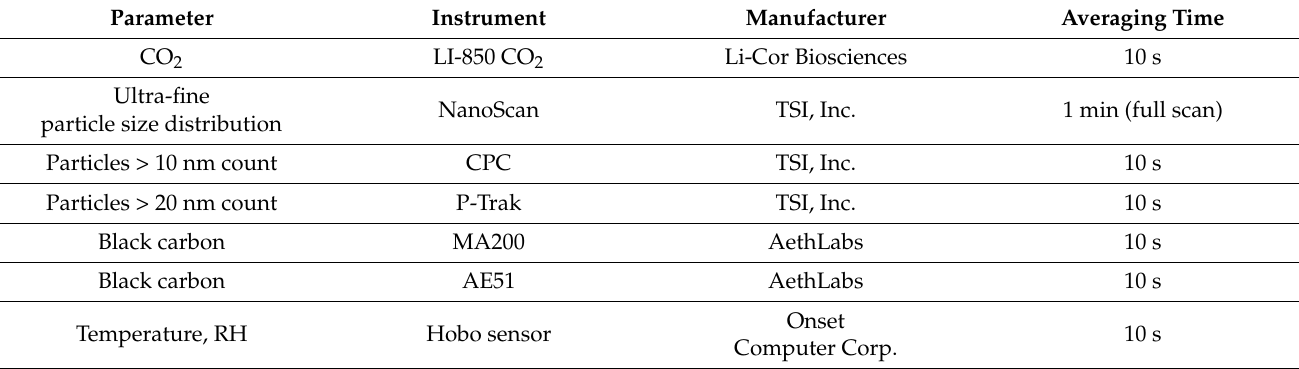
Table 2. Air quality instruments used to measure conditions in classroom and ambient